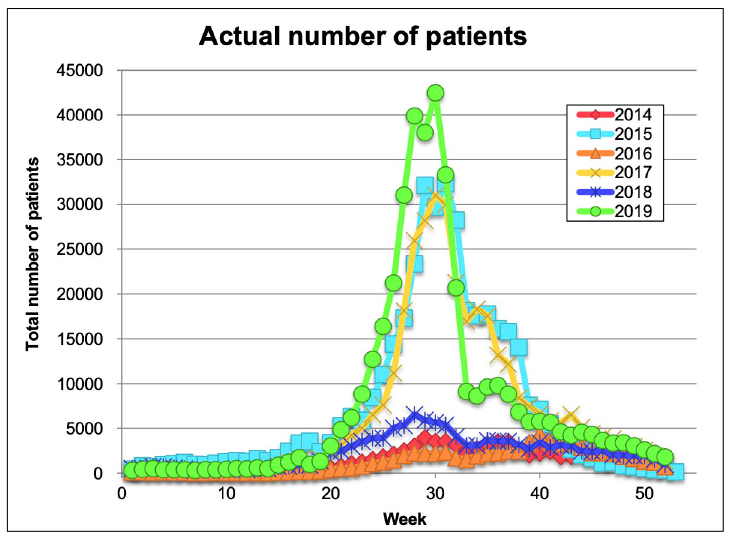
Fig 5. Actual epidemic patterns in 2014–2019. Actual numbers of patients in weeks 1–52 or 1–53.